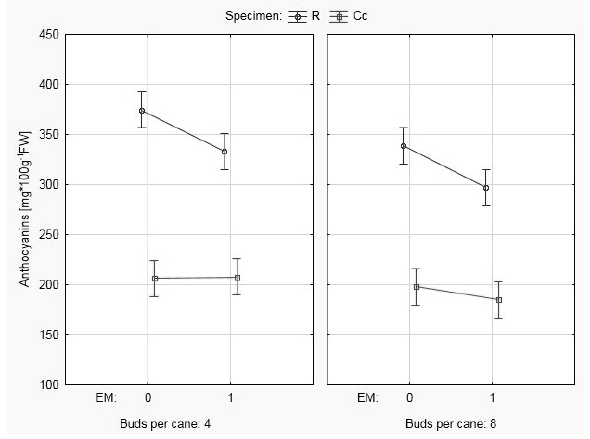
Fig. 2: Effect of the performed treatments on anthocyanin content (in mg 100 g -1 FW) in the fruits of the tested vine cultivars .